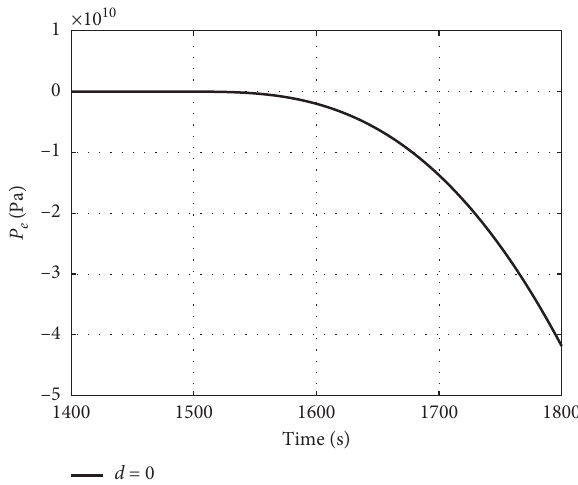
Figure 7: Pressure error caused by the pressure sensor